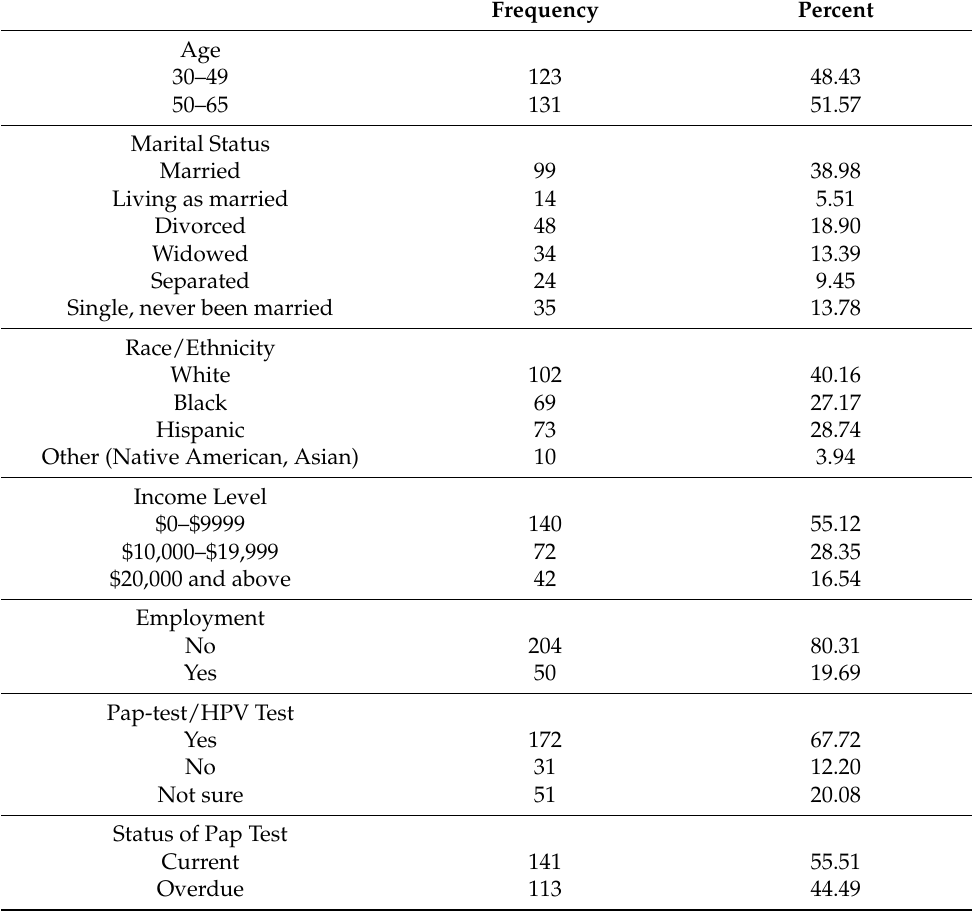
Table 1. Demographic characteristics, screening behavior, knowledge, and preference among the participants ( n =